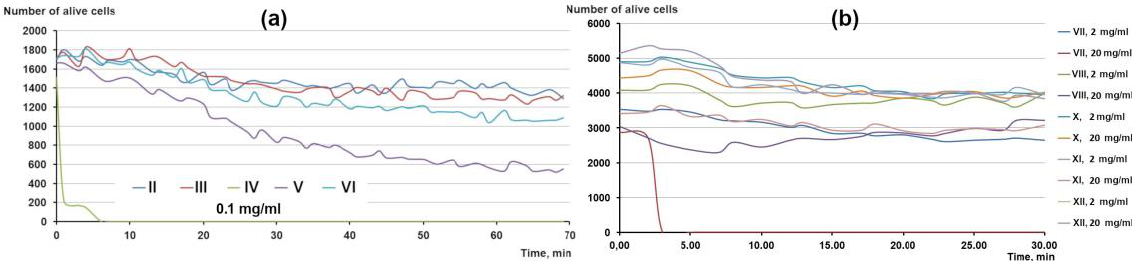
Figure 3. Toxicity to Tetrahymena of the fractions obtained by gel-filtration to Tetrahymena . ( a ) Activ- ity of fractions I-VI at concentration of 0.1 mg/mL. ( b ) Activity of fractions VII-XII at concentrations of 2 and 20 mg/mL.